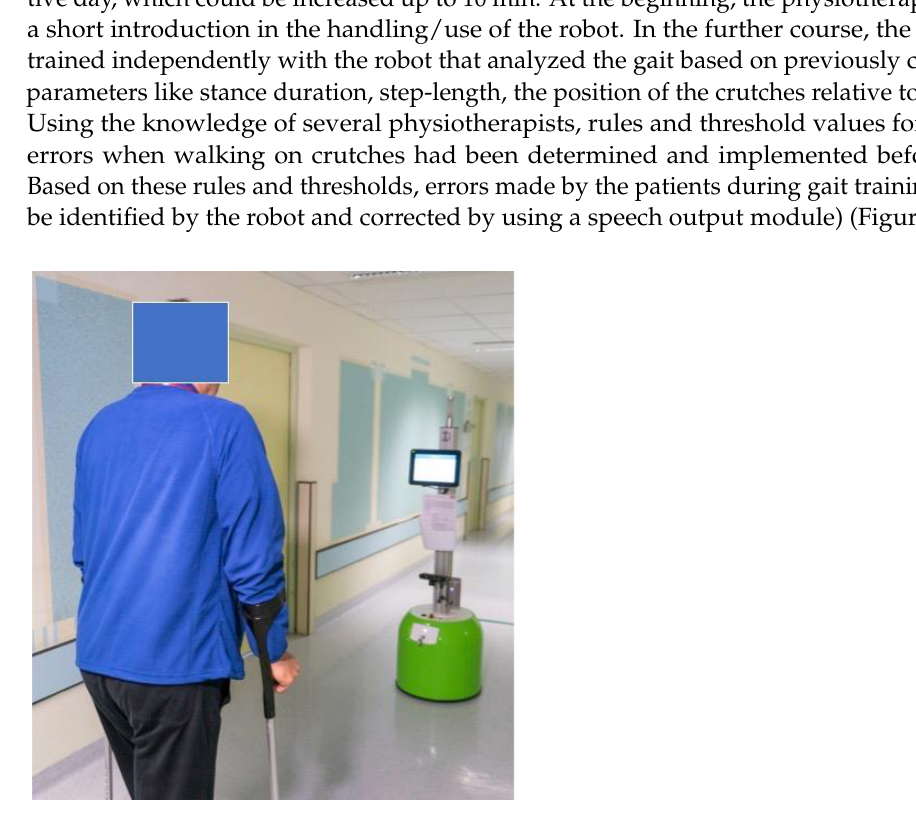
Figure 2. A patient after hip arthroplasty using crutches during the gait training with the